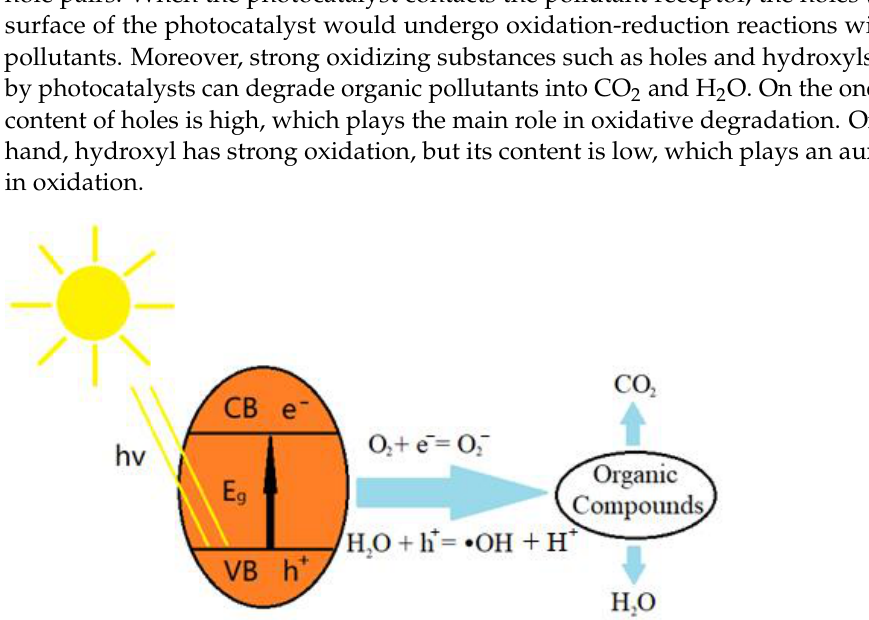
Figure 1. The photocatalytic mechanism for photocatalysts under simulated solar irradiation.